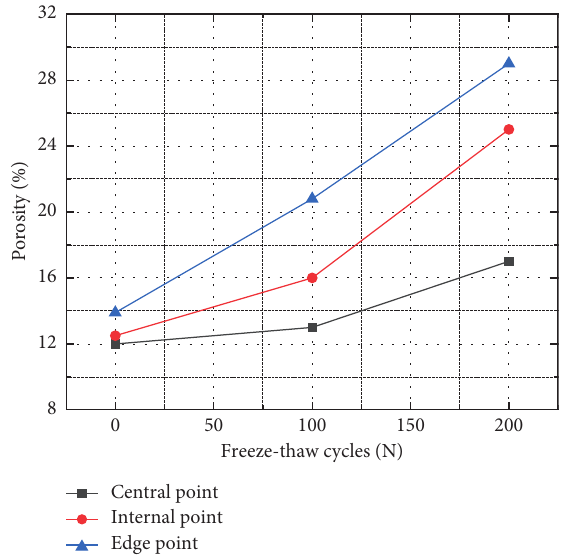
Figure 9: The effect of freeze-thaw cycles on the porosity of uncorroded specimens.